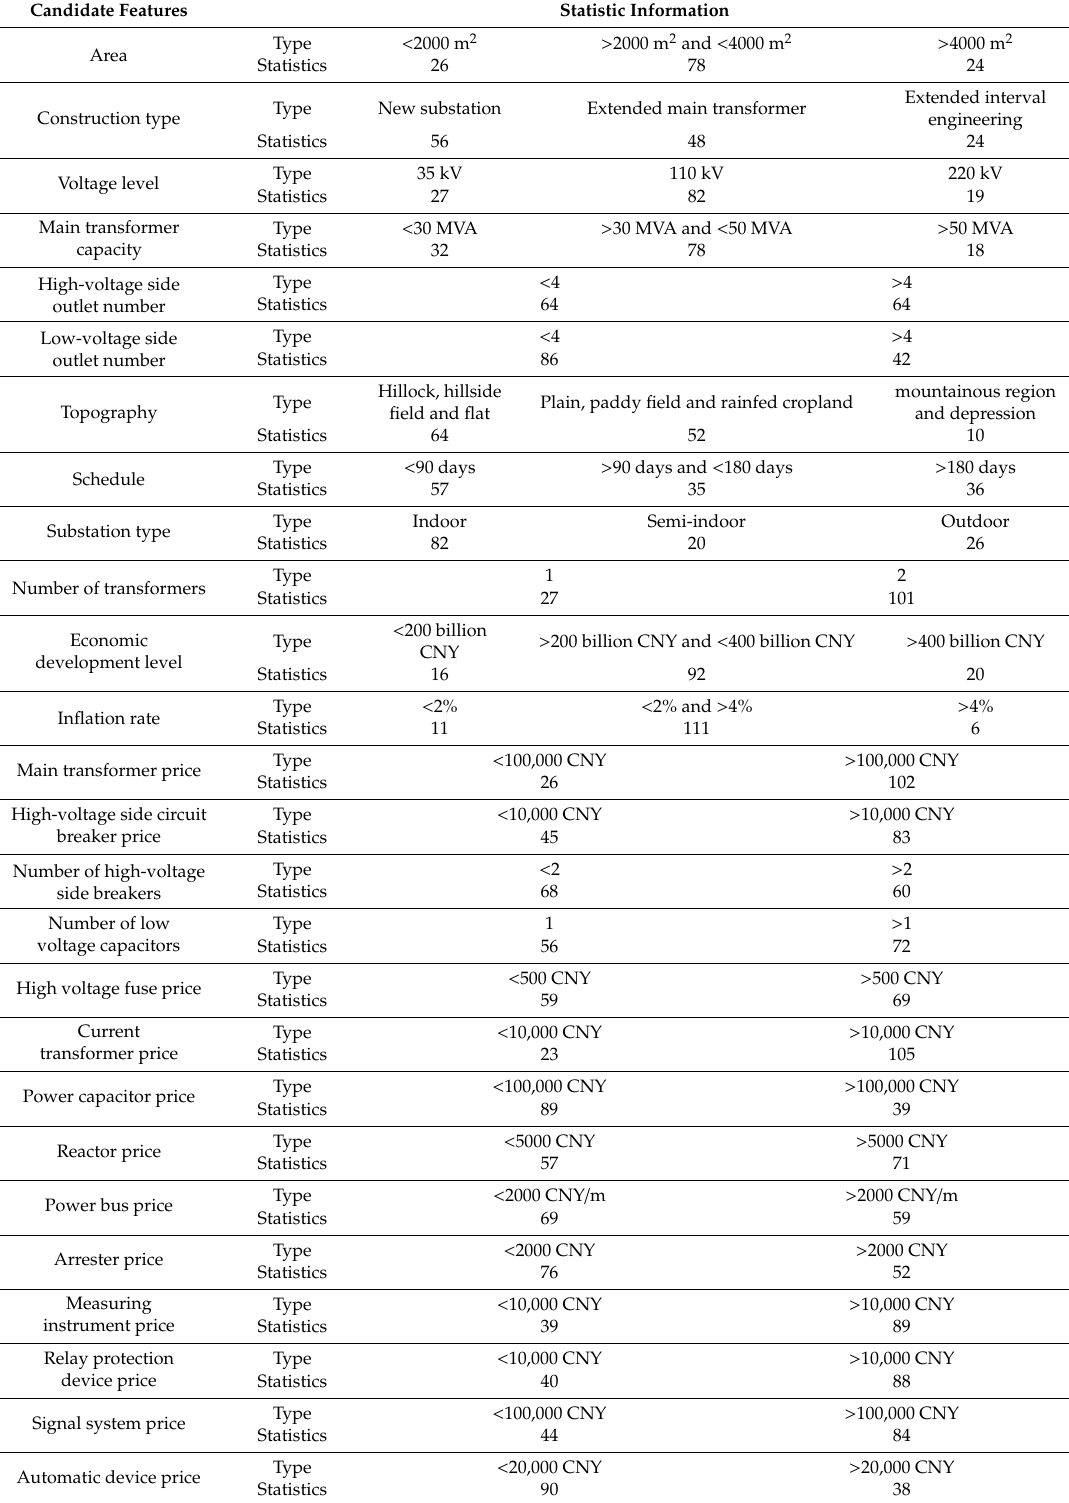
Table A1. The statistics of substation